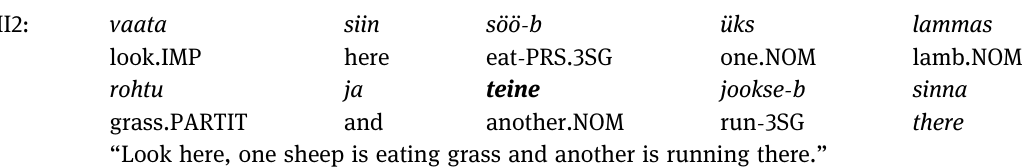
Quanti fi er phrases were used three times ( kaks last “ two children, ” kolm kitse “ three goats ” and kitsetallekesed kolm “ three baby goats ” ) and only for baby goats. A personal pronoun ( ta “ she/he ” ) ,